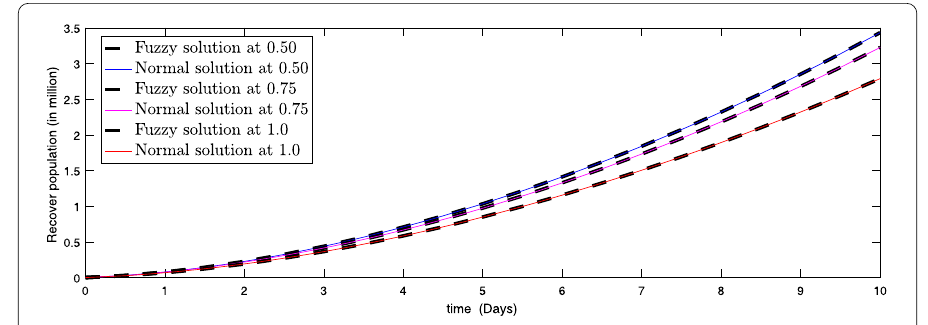
Figure 4 Comparison of approximate fuzzy and normal solution for recovered compartment for three terms at the given uncertainty values α ∈ [0,1] against various fractional order